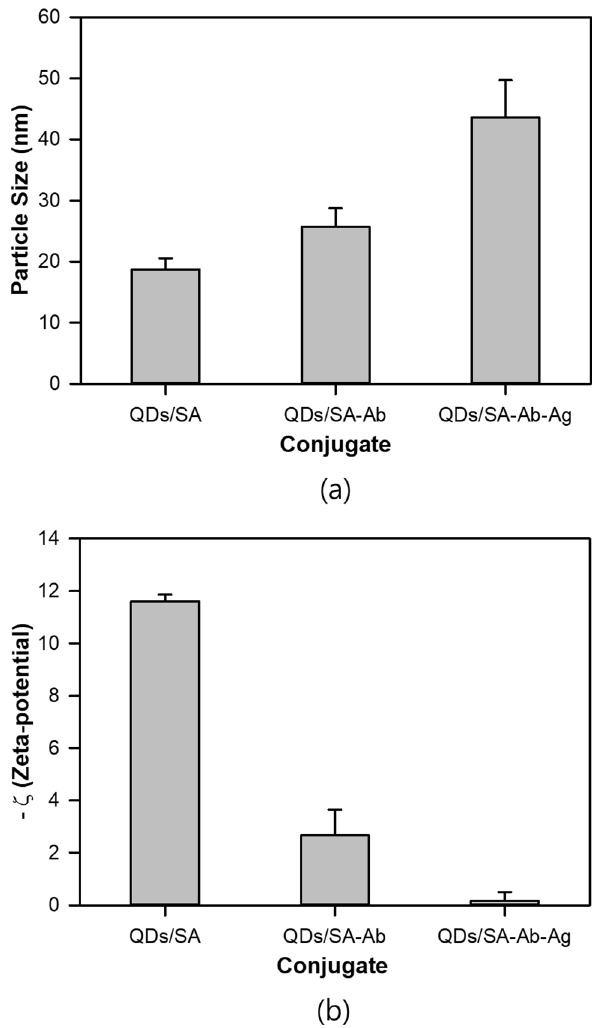
Figure 4. ( a ) Hydrodynamic particle size of QDs/SA, QDs/SA-Ab, QDs/SA-Ab-Ag, ( b ) zeta potential of QDs/ SA, QDs/SA-Ab,